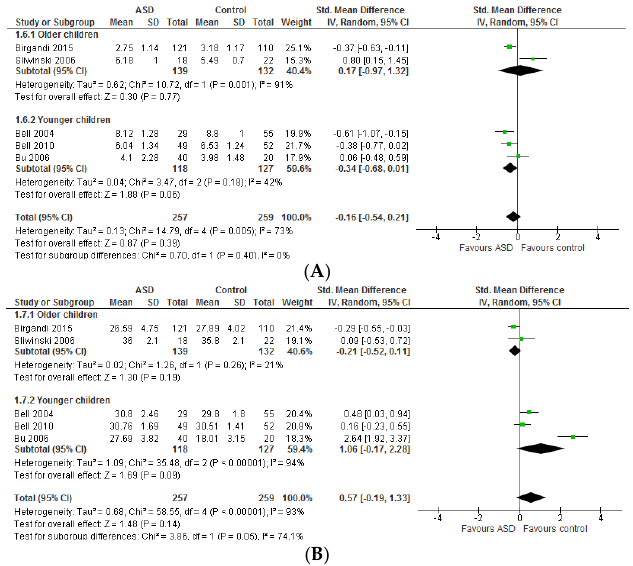
Figure 4. Forest plots of mean (95% confidence interval (CI)) weighted difference in the total n ‐ 3 long chain polyunsaturated fatty acids ( n ‐ 3 LCPUFA) ( A ) and total n ‐ 6 long chain polyunsaturated fatty acids ( n ‐ 6 LCPUFA) ( B ) between populations with Autism Spectrum Disorder (ASD) and typically developing children stratified for subgroups with studies including all age groups (children, teenagers, and adults) vs. young children only. Direction of effect (negative, lower mean in ASD group; positive, lower mean in control group; zero, no difference between groups).